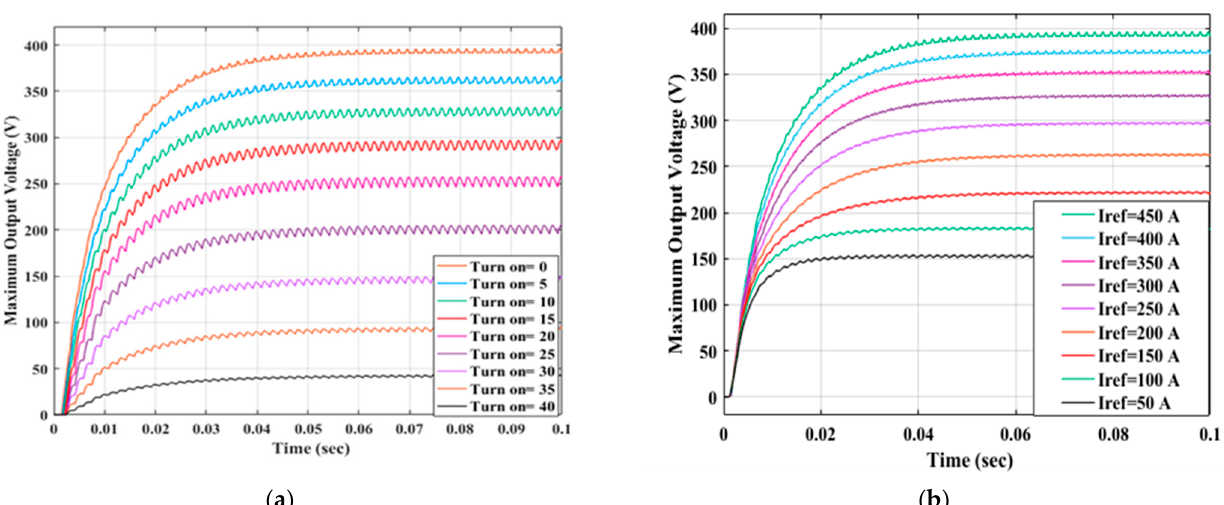
Figure 9. Maximum generated output voltage in volt at ( a ) different initial turn-on angle in deg, ( b ) different reference maximum input current